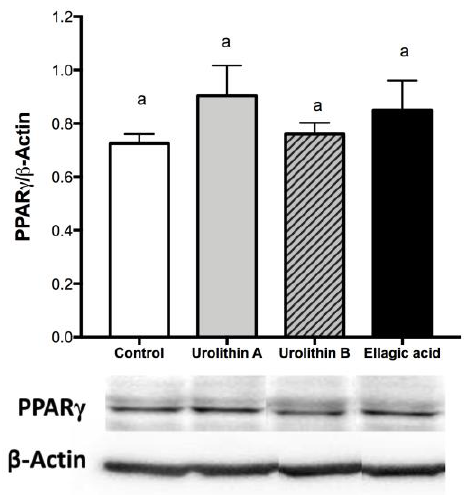
Figure 3. Effect of ellagic acid, urolithin A, and urolithin B over PPARγ protein expression at day 4 after differentiation induction. 3T3-L1 cells were treated with 25 μM of each compound. For control samples, 0.025% DMSO was used. The values represent the mean ± SD ( n = 3) of three independent experiments. Different letters among bars denote significant changes among treatments and control ( p ≤ 0.05) performed by ANOVA and Tukey’s post hoc test.